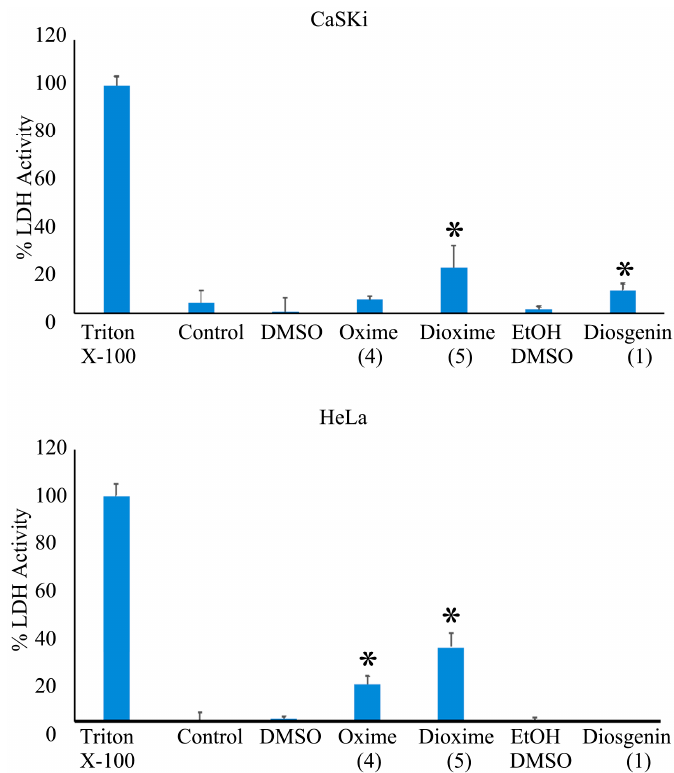
Figure 4. Evaluation of cytotoxicity for compounds 1 , 4 , and 5 on cervicouterine cancer cell lines. Cells were seeded in 96-well tissue culture plates at 7500 cells/well. After 24 h the medium was removed and cells were exposed to compounds 1 , 4 , and 5 at the respective IC 50 concentrations or with EtOH/DMSO 3:1 or DMSO (10 µ L/mL) and evaluated after 24 h by the amount of LDH released in the culture supernatant. Experimental data are described as mean ± S.D. of three independent experiments with three repetitions * p < 0.05 versus ethanol or DMSO (Student’s t -test).